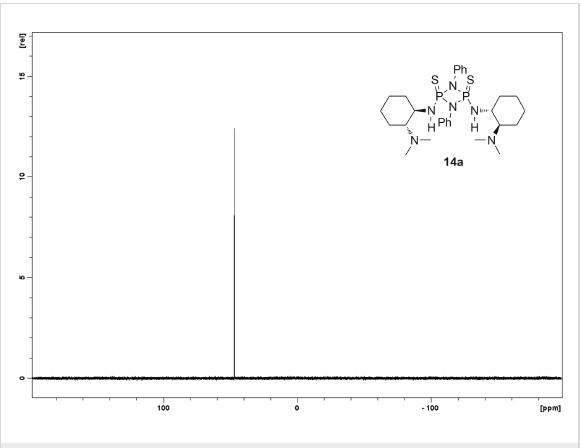
Figure 6: 31 P{1H} NMR spectrum in CDCl 3 at rt showing C 2 symmetry of 14a at rt.